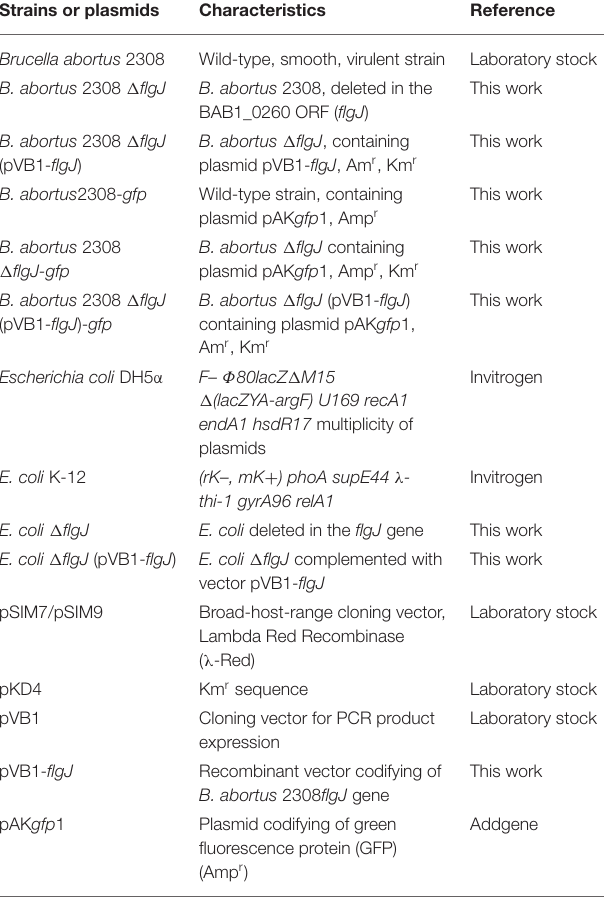
TABLE 1 | Bacteria and plasmids used in this study. TABLE 2 | Primers used in this study within the genome framework of B. abortus